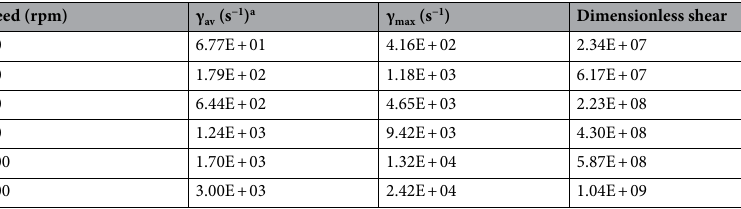
Table 3. Stirring speeds and corresponding average (γ av ) and maximum (γ max ) shear rates for a 1 L bioreactor equipped with one pitched-blade impeller. a The average shear values were generated by Sánchez Pérez, Rodríguez Porcel 46 with Eq. (5), for an A315 axial flow hydrofoil impeller (LIGHTNIN Mixers, Rochester, NY), which is similar to a pitched-blade stirrer.